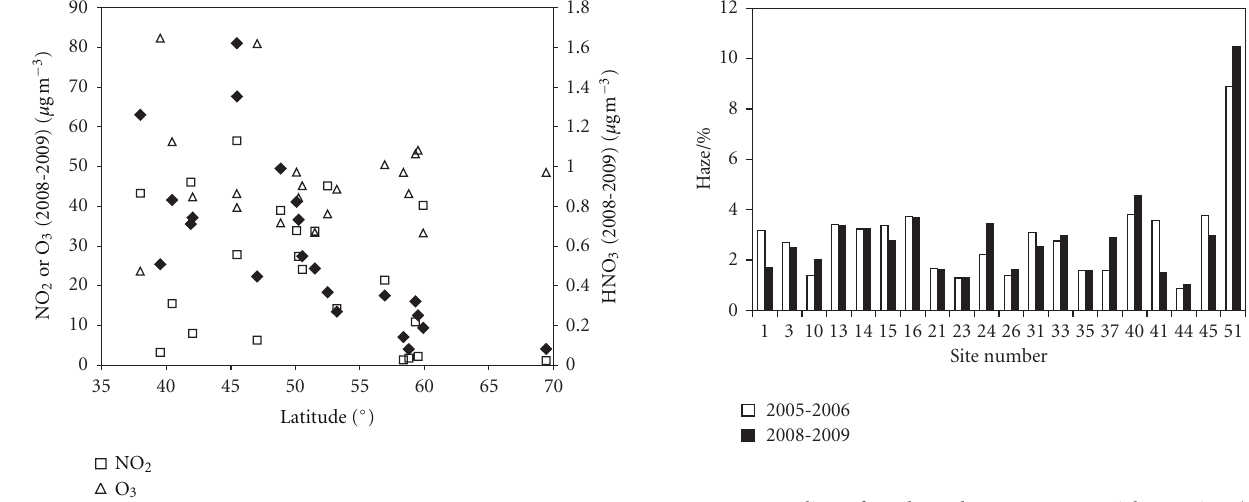
Figure 10: Soiling of modern glass at ICP Materials test sites (see Table